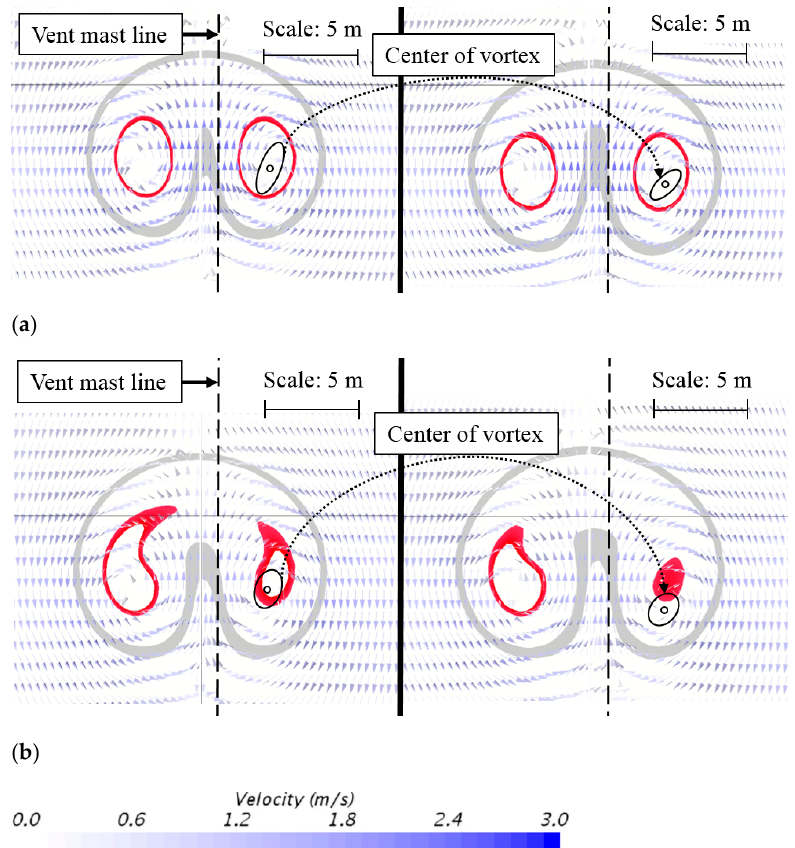
Figure 13. Contour lines of the FL and the tangential velocity of fluid. The left side of the figure shows the cross section at a drifting distance of 100 m; the right side of the figure represents the results for a drifting distance of 110 m. Different directions of vent-mast outlets for scenarios are shown: ( a ) is for the outlet with both upward and downward emission, while ( b ) is for the outlet with downward emission. The relative wind speed is 10 m/s for both scenarios